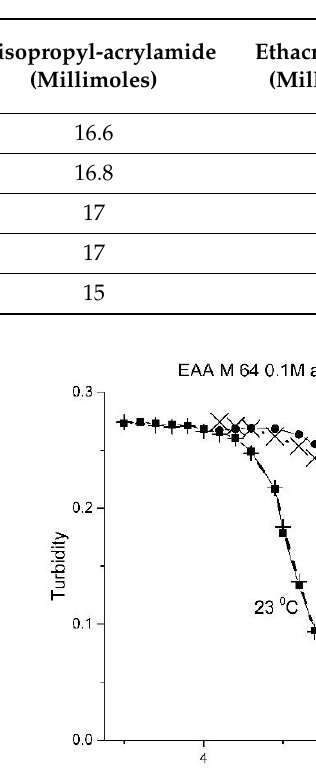
Figure 6. Ascending pH profiles at 37 °C for a variety of N -isopropylacrylamide copolymers of ethacrylic acid: M-64, M-71, M-72, M-80, and M-83. Table 4. Formulations of N -isopropylacrylamide Copolymers of Ethyacrylic Acid.